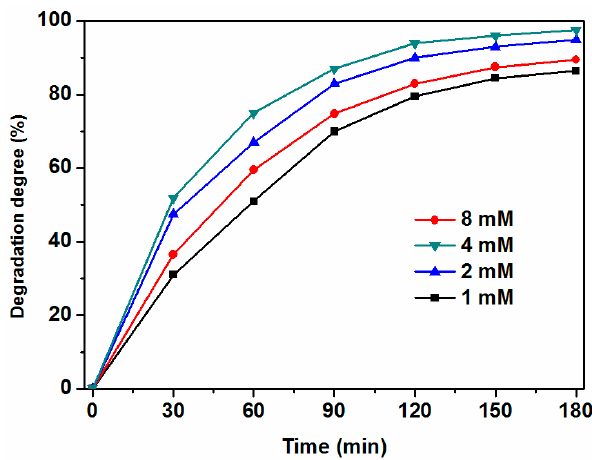
Figure 2. Effects of different KPS dosages on the photodegradation rate of HBCD (the initial concentration of HBCD is 25 mg/L, and TiO 2 dosage is 100 mg/L).